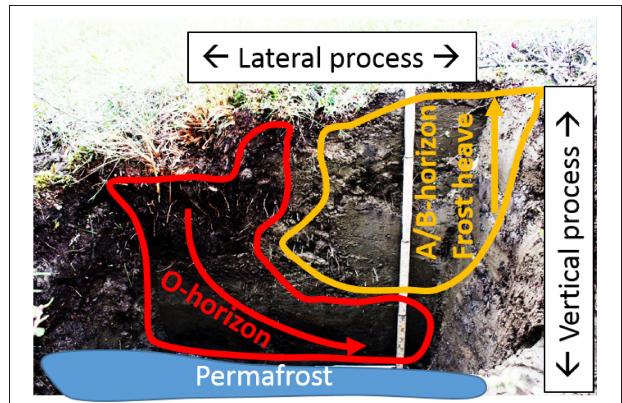
FIGURE 1 | Cross section of a non-sorted circle from Kolyma River lowlands, Russia. The light color mineral soil material (B/C horizon) is affected by vertical movement due to frost heave (in yellow). At the inter-circle, brown organic rich soil material (O/A horizon) accumulated at the soil surface is moving downwards toward the permafrost table (in red). Photo from Gustaf Hugelius, Stockholm University, Sweden.